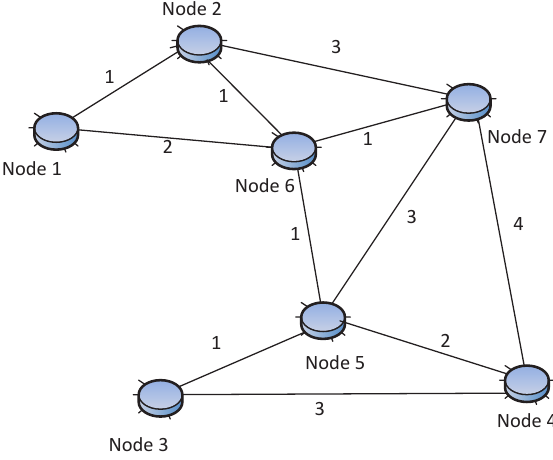
Figure 2. WSN topology example. (1) | V | = 7, | E | = 11; (2) This is the non-negative weighted edge undirected connected graph; (3) Four nodes, 6, 3, 7 and 4, are neighbors ) = 4 ; (4) Network degree δ = 2 ; (5) This is two-connected and of Node 5, so d ( v 5